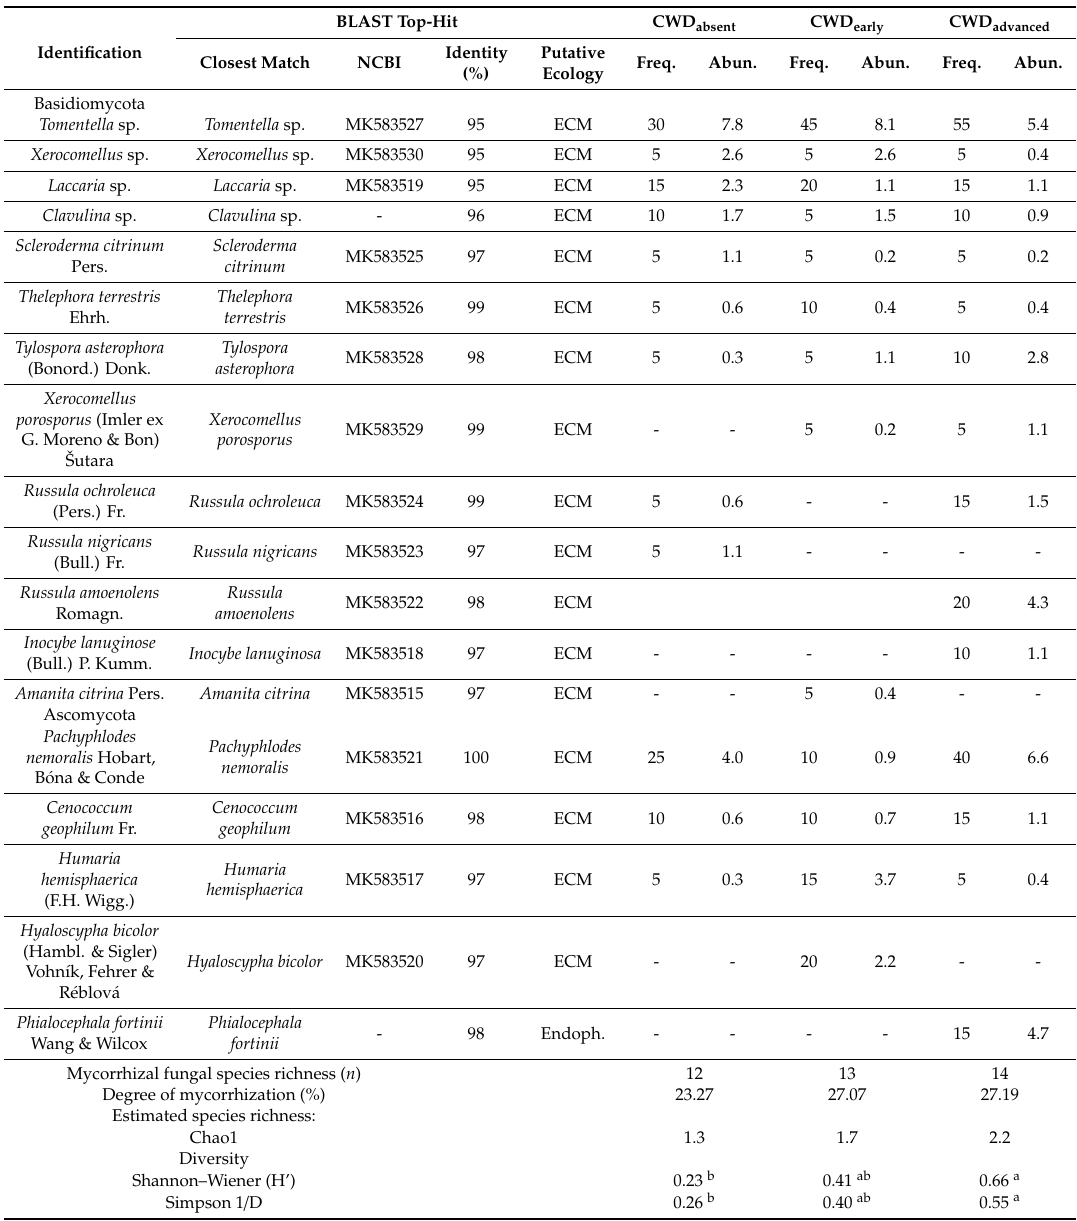
Table 3. Estimated species richness, diversity, and occurrence of fungal taxa associated with the roots of oak trees in the three study sites, characterized based on the absence of coarse woody debris (CWD absent ) and early (CWD early ) and advanced (CWD advanced ) stages of wood decay. Data are the frequency (Freq.; percent of colonized plants) and abundance (Abun.; percent of mycorrhizal roots colonized) of fungal taxa on root tips. Abbreviations: ECM—ectomycorrhizal fungus, Endoph.—endophyte. Di ff erent letters indicate significant di ff